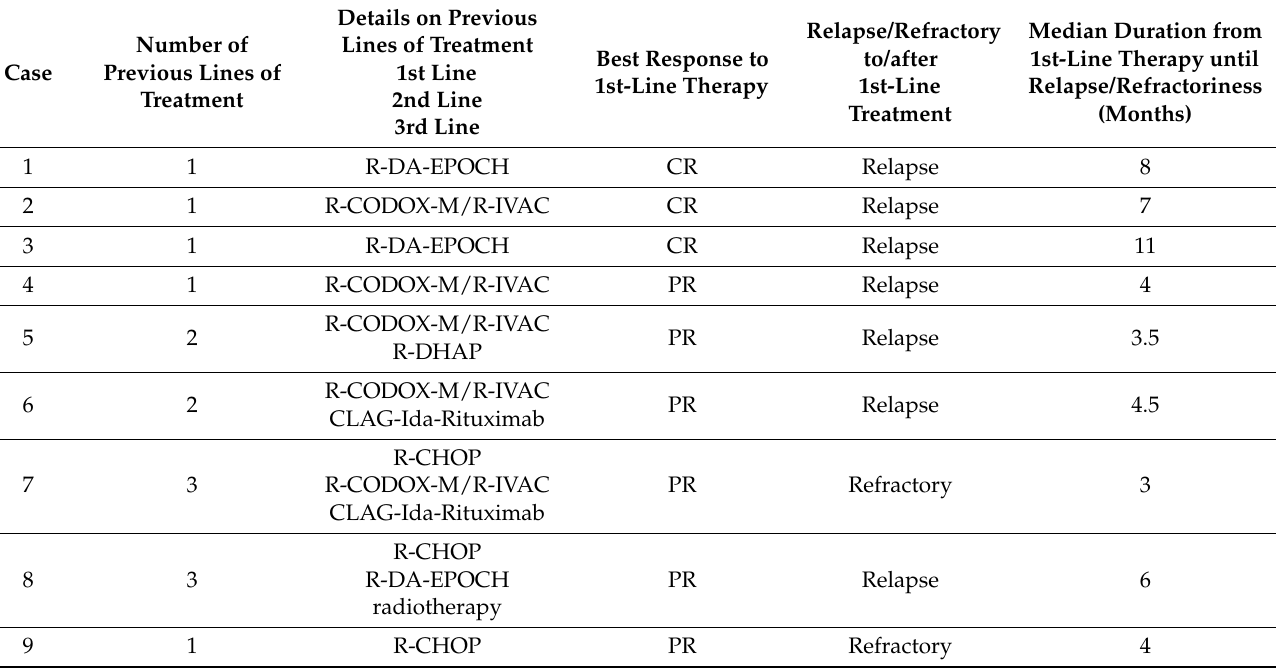
Table 2. Previous lines of treatment before